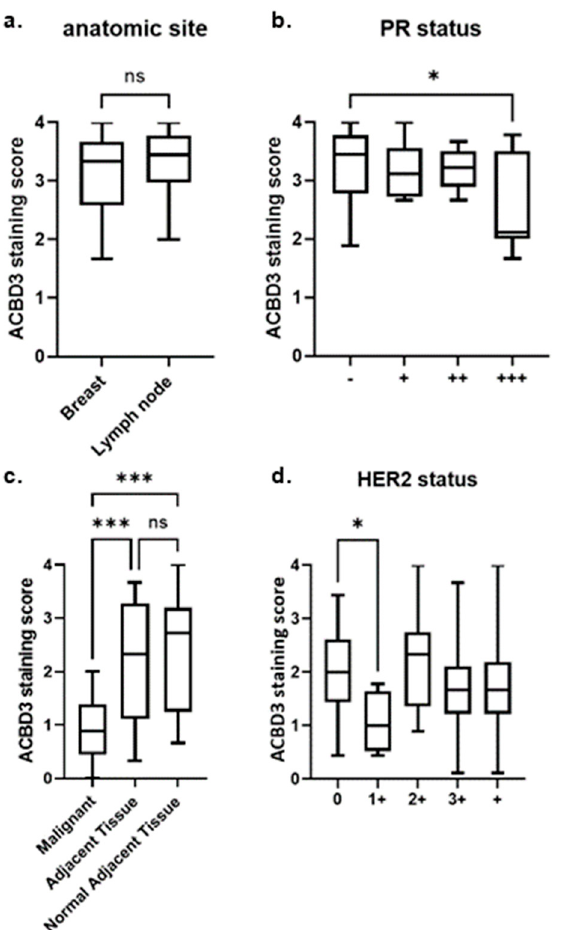
Figure 8. ACBD3 staining score of US BIOMAX fixed breast tissue core arrays. ( a ) Array BR1008B, there was no statistical difference in ACBD3 staining between malignant breast tissue ( n = 48) and metastatic breast cancer of the lymph node ( n = 38). ( b ) Array BR1008B, ACBD3 protein expression was significantly higher in PR negative breast cancer cores ( n = 50) compared to PR 3+ cores ( n = 9) (malignant breast tissue and metastatic lymph tissue, * p = 0.02202), but there was no statistical difference between PR − samples compared to all grades of PR+ core (not shown). ( c ) Array BC08032a, ACBD3 protein levels are significantly lower in malignant tissue compared to either cancer-adjacent tissue or normal-adjacent tissue, *** p < 0.001; ns = not significant ( d ) Array BR1401, there was a statistically significant difference between HER2 − (grade 0) breast cancer samples and HER 1+ samples, * p = 0.0107. Error bars represent the standard deviation.